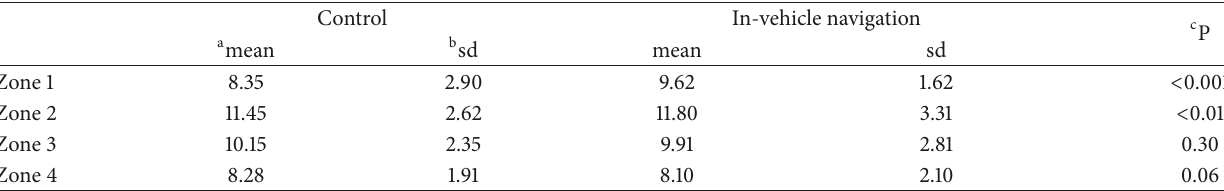
Table 2: Statistical results of the number of fixations.